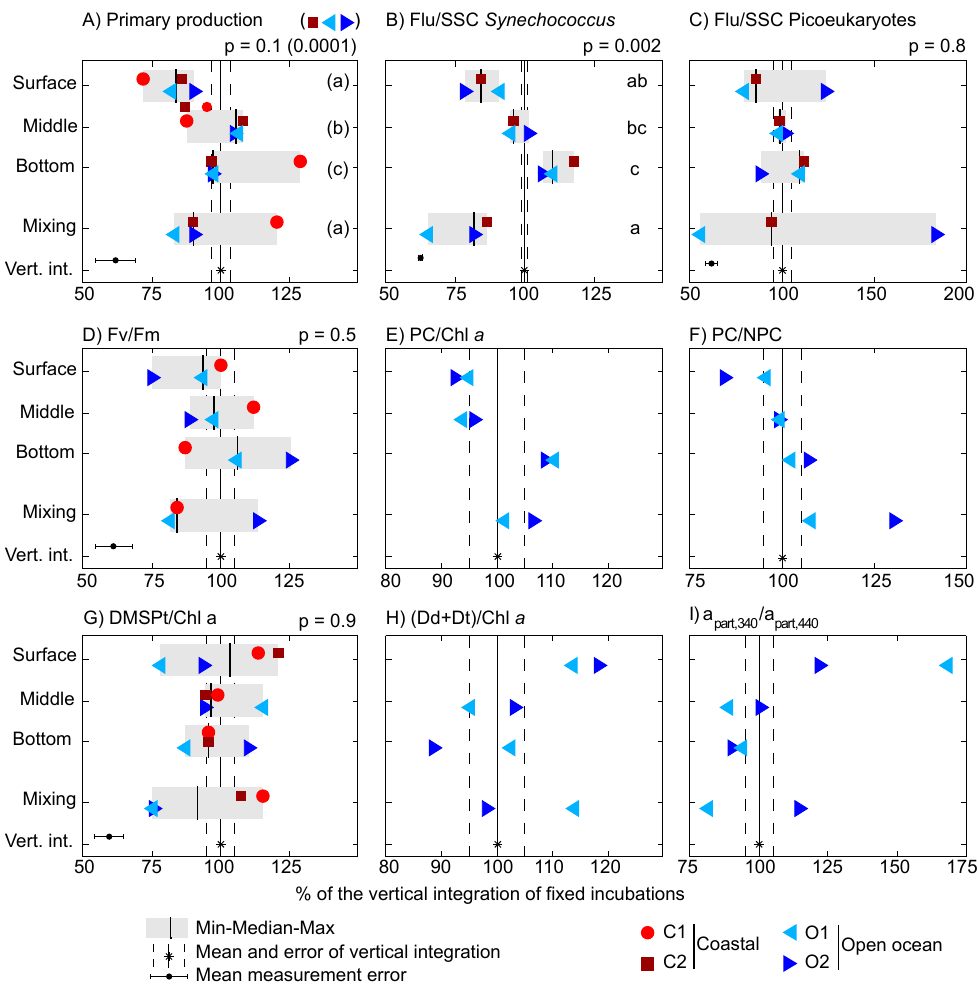
Fig. 4. Response of phytoplankton to irradiance gradients in static and vertically moving incubations. Primary production rates (a) and in- dicators of phytoplankton photoresponse (b–i) have been normalized, within each experiment, to the vertical integral of fixed incubations. Flu/SSC: side-scatter-normalized cell-specific fluorescence. F v / F m : maximum quantum yield of photosystem II photochemistry. PC: pho- tosynthetic carotenoids. NPC: non-photosynthetic carotenoids. Dd: diadinoxanthin. Dt: diatoxanthin. a p , 340 / a p , 440 : ratio of particulate light absorption coefficient at 340nm and 440nm. Differences between treatments are represented by p values of ANOVA tests followed by multiple comparisons (see text for details). In (a) , a test was performed on a subset of experiments (C2, O1 and O2) that exhibited a more coherent response, and the resulting p value and multiple comparisons are shown in